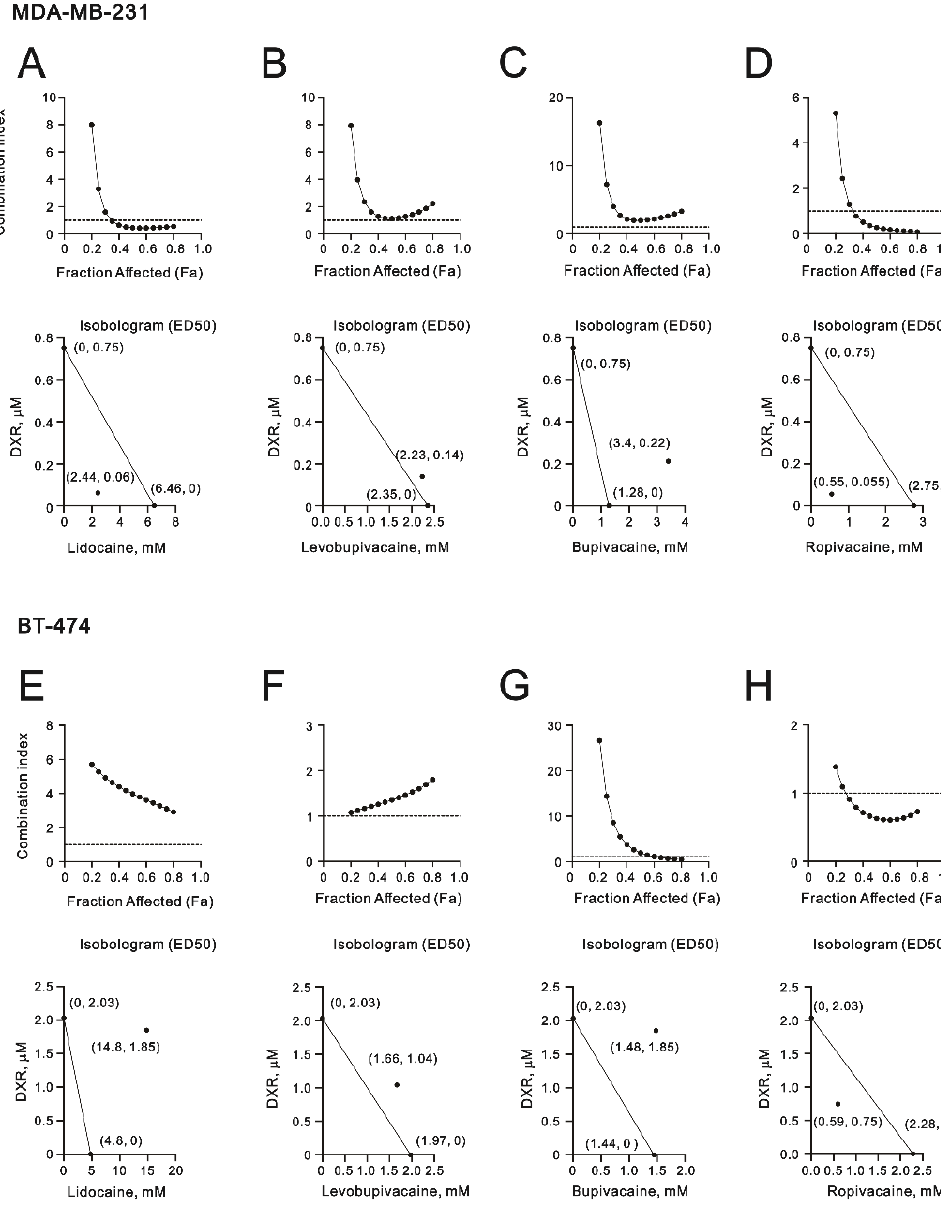
Figure 8. The combination indices of the local anesthetics with DXR in MDA-MB-231 and BT-474 cells. ( A – H ) The combination indices of DXR plus lidocaine, levobupivacaine, bupivacaine, and ropivacaine in ( A – D ) 1.5 × 10 4 MDA-MB-231 cells and ( E – H ) 2.5 × 10 4 BT-474 cells; ( A – D ) MDA-MB- 231 cells were treated with various DXR doses (0, 0.01, 0.025, 0.05, 0.1, 0.25, 0.5, and 1 µ M) combined with various lidocaine doses (0, 0.156, 0.3125, 0.625, 1.25, 2.5, 5, 10, 20, and 40 mM), levobupivacaine doses (0, 0.03125, 0.0625, 0.125, 0.25, 0.5, 1, 2, 4, and 8 mM), bupivacaine doses (0, 0.0156, 0.03125, 0.0625, 0.125, 0.25, 0.5, 1, 2, and 4 mM), and ropivacaine doses (0, 0.0625, 0.125, 0.25, 0.5, 1, 2, 4, 8, and 10 mM); (E,F, G, H) BT474 cells were treated with various DXR doses (0, 0.156, 0.3125, 0.625, 1.25, 2.5, 5, and 10 µ M) combined with various lidocaine doses (0, 0.156, 0.3125, 0.625, 1.25, 2.5, 5, 10, 20, and 40 mM), levobupivacaine doses (0, 0.03125, 0.0625, 0.125, 0.25, 0.5, 1, 2, 4, and 8 mM), bupivacaine doses (0, 0.0156, 0.03125, 0.0625, 0.125, 0.25, 0.5, 1, 2, and 4 mM), and ropivacaine doses (0, 0.03125, 0.0625, 0.125, 0.25, 0.5, 1, 2, 4, and 8 mM) for 24 h. Metabolic activity was measured using the MTT method. The isobolograms (ED50) of lidocaine, levobupivacaine, bupivacaine, and ropivacaine were calculated using CalcuSyn